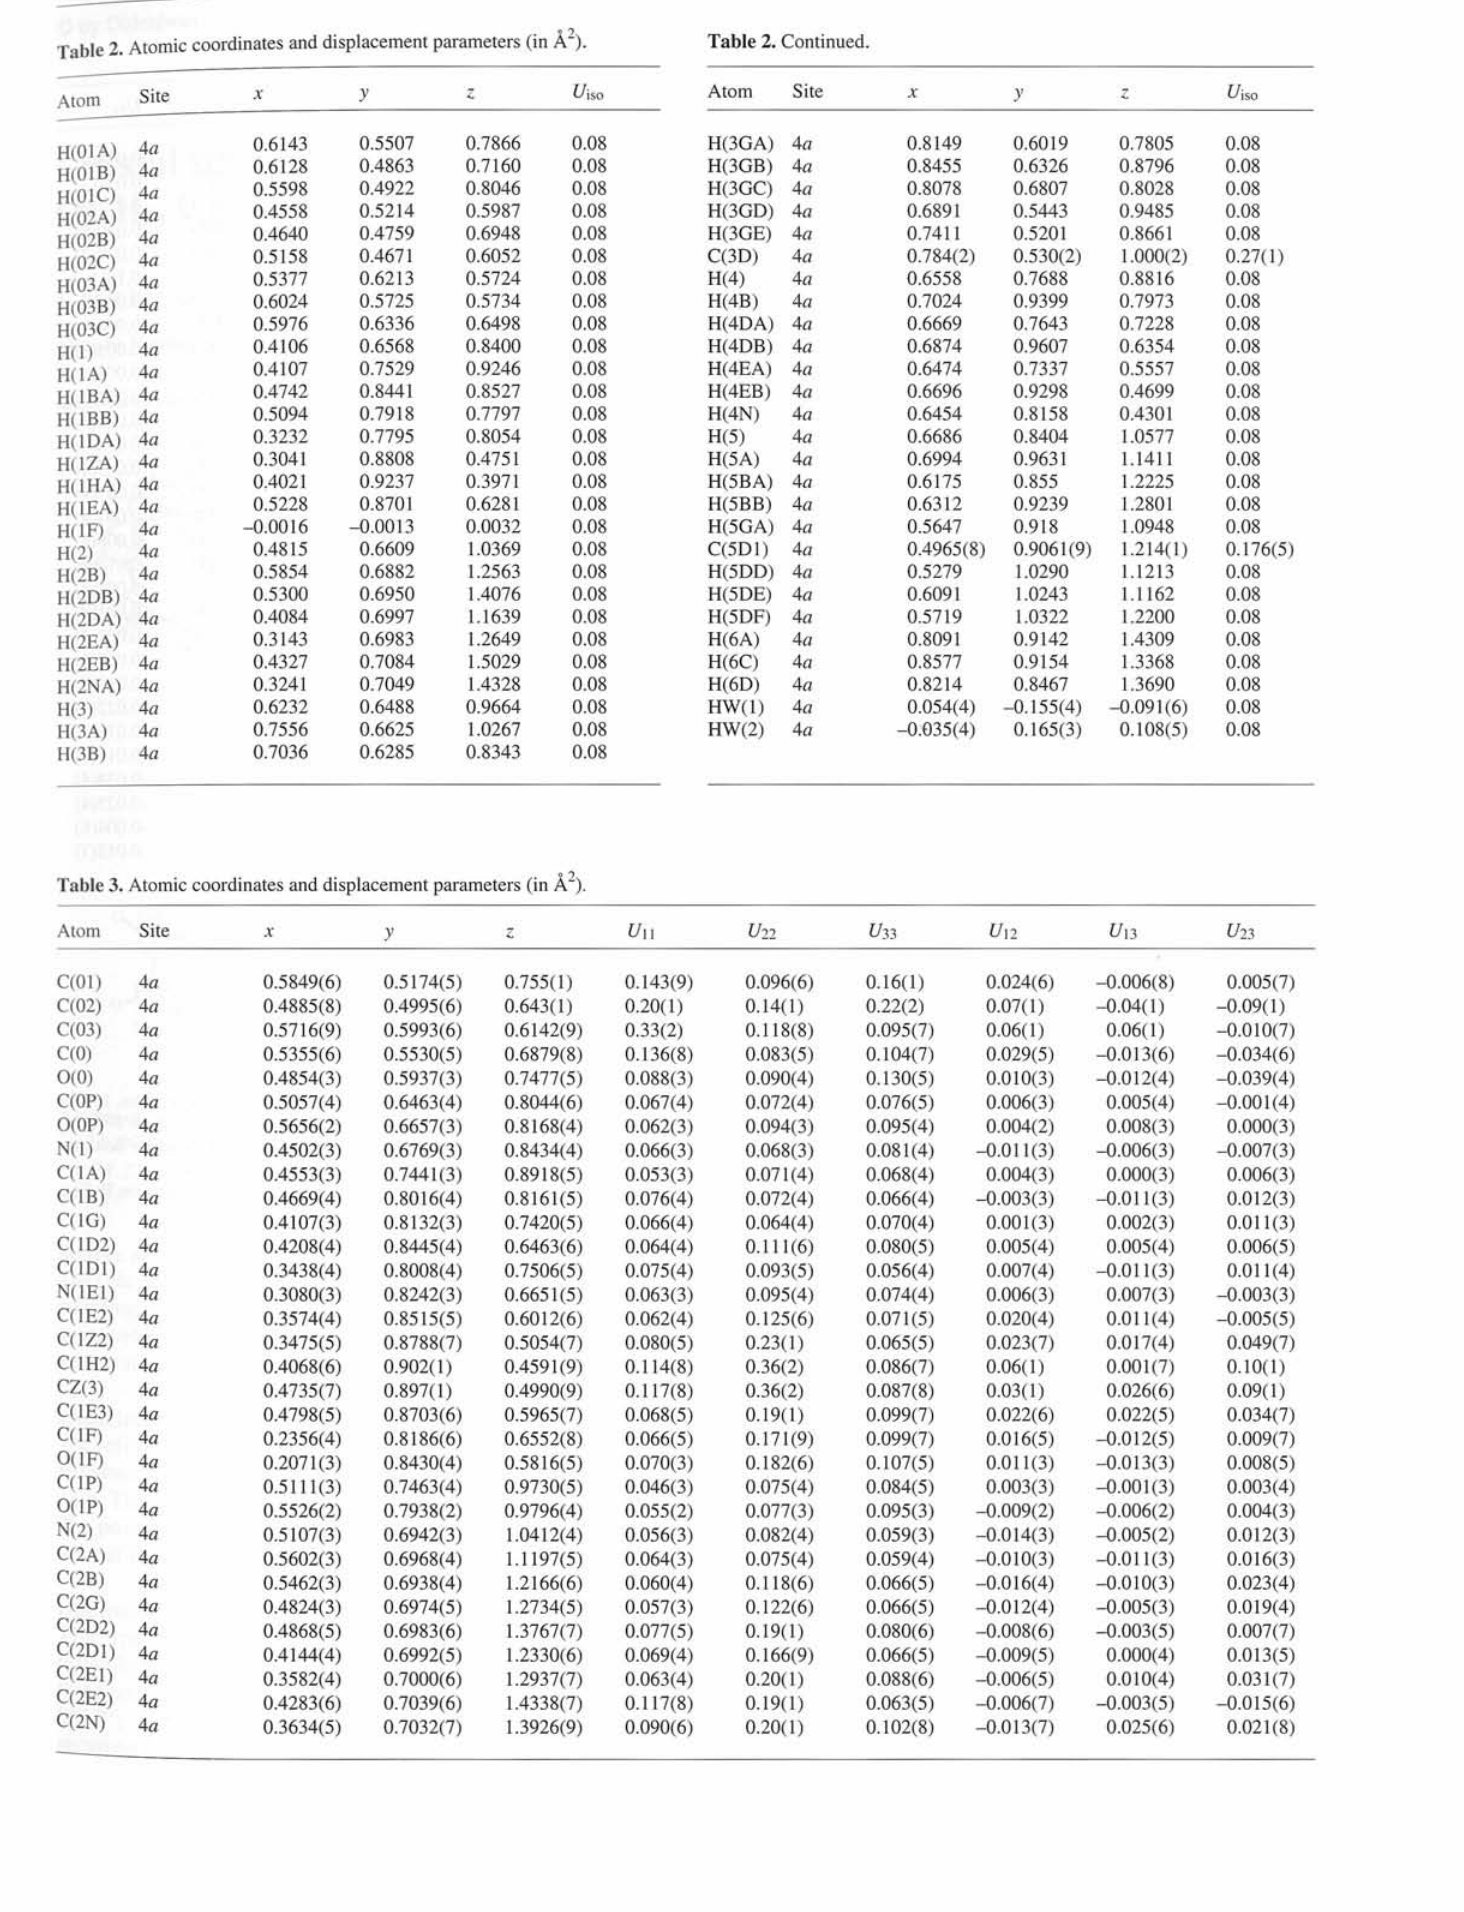
Table 3. Atomic coordinates and displacement parameters (in Â 2